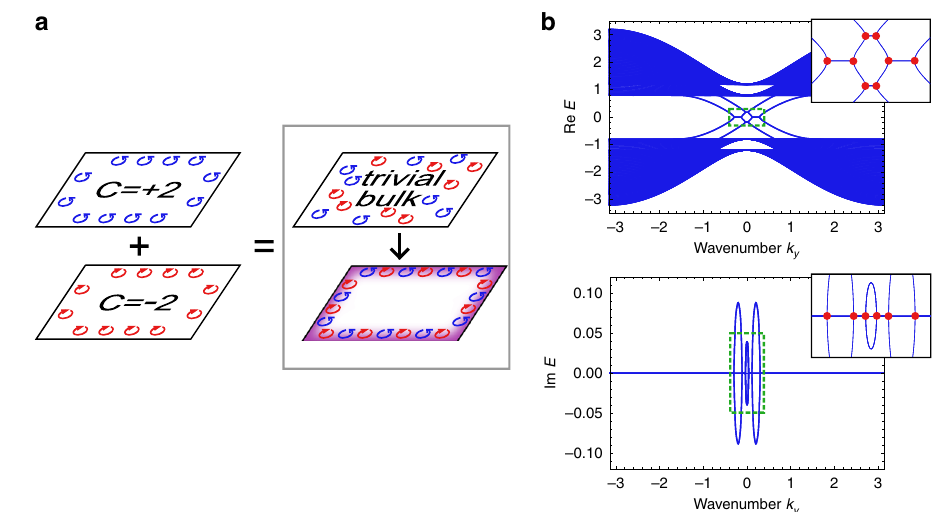
Fig. 1 Schematic fi gure and prototypical band structure of exceptional edge modes. a The system consists of two Chern insulators, which have the Chern numbers with the same absolute values and the opposite signs. If we consider Chern insulators with even Chern numbers, the bulk of the combined system becomes topologically trivial. However, when we use a non-Hermitian coupling to combine two Chern insulators, robust gapless modes can appear at the edge of the sample. b Two-layered non-Hermitian Bernevig-Hughes-Zhang model is considered to demonstrate the prototypical band structure of exceptional edge modes. We numerically calculate the edge band structure of the 1 × 50 ribbon-shaped system under the open boundary condition in the x direction and the periodic boundary condition in the y direction. The parameters used are u = − 1, c = 0.2, β = 0.14, β 0 ¼ 0 : 06, and γ = 0.05. Four gapless bands per edge exist in the bulk energy gap (they are doubly degenerate) and thus imply the topologically trivial bulk of the system. In the edge bands, we also fi nd exceptional points (EPs) (indicated by red points in the insets), which are the wavenumbers at which the edge eigenstates coalesce and the Hamiltonian becomes nondiagonalizable. We can con fi rm that the imaginary parts of the eigenenergies appear from the EPs. These EPs play the role of the glue of the edge modes and thus prevent gap opening by perturbations or disorders, which is shown in Fig.